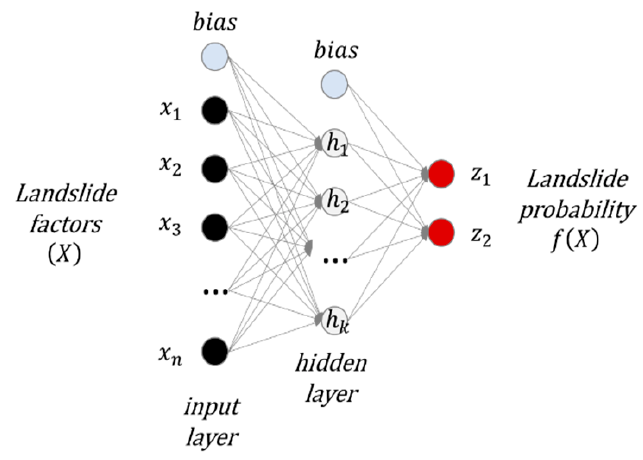
Figure 4. The architecture of a feed-forward neural network.